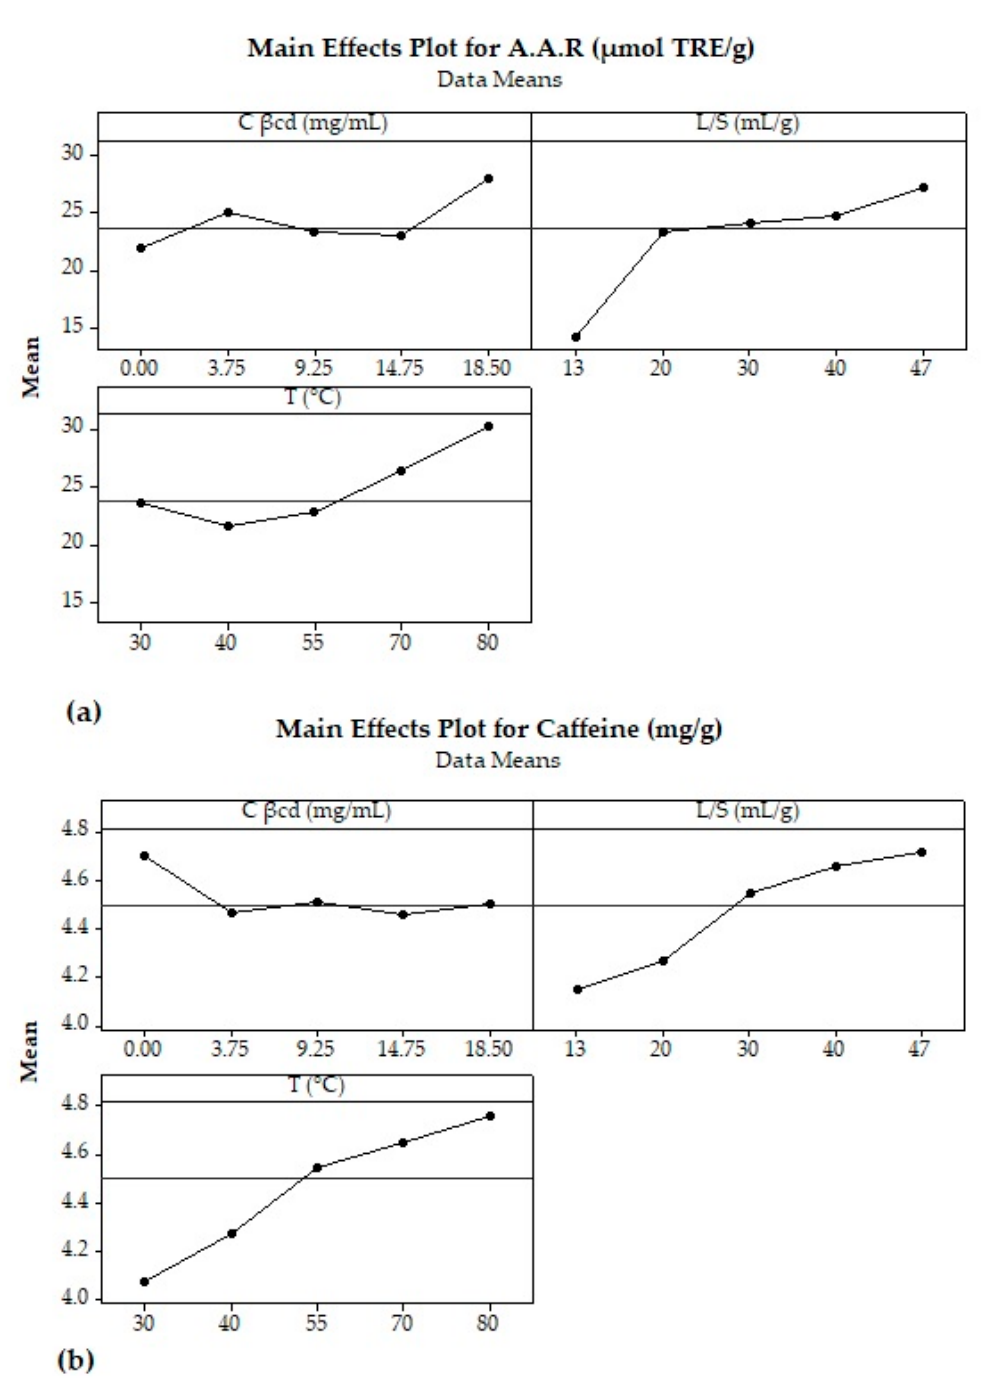
Figure 1. Main e ff ects plots presenting the e ff ect of β -cyclodextrin concentration (C β cd , mg / mL), Figure 1. Main effects plots presenting the effect of β -cyclodextrin concentration (C β cd , mg/mL), liquid- liquid-to-solid ratio (L / S, mL / g), and temperature (T, ◦ C) ( a ) on extract antiradical activity (A AR , µ mol to-solid ratio (L/S, mL/g), and temperature (T, °C) (a) on extract antiradical activity (A AR , μ mol TRE/g) TRE / g) and ( b ) on ca ff eine extraction yield (C Caf and (b) on caffeine extraction yield (C Caf ).